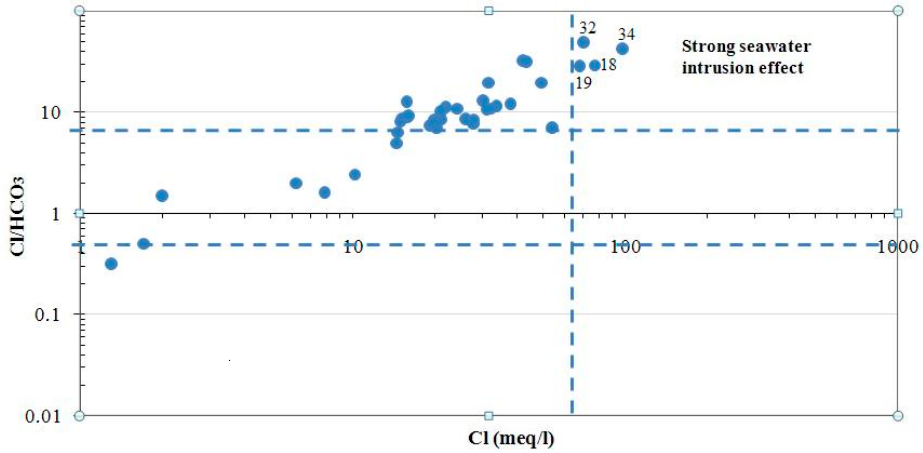
Figure 6. Relationship Cl/HCO 3 vs. Cl in groundwater of the Sfax coastal shallow aquifer.